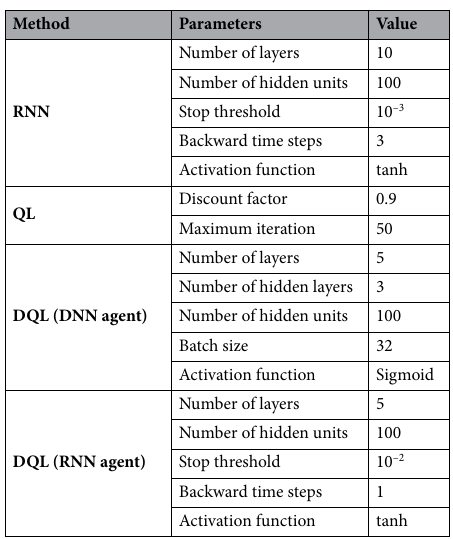
Table 1. The internal structure of the learning methods used in the proposed SAAD.